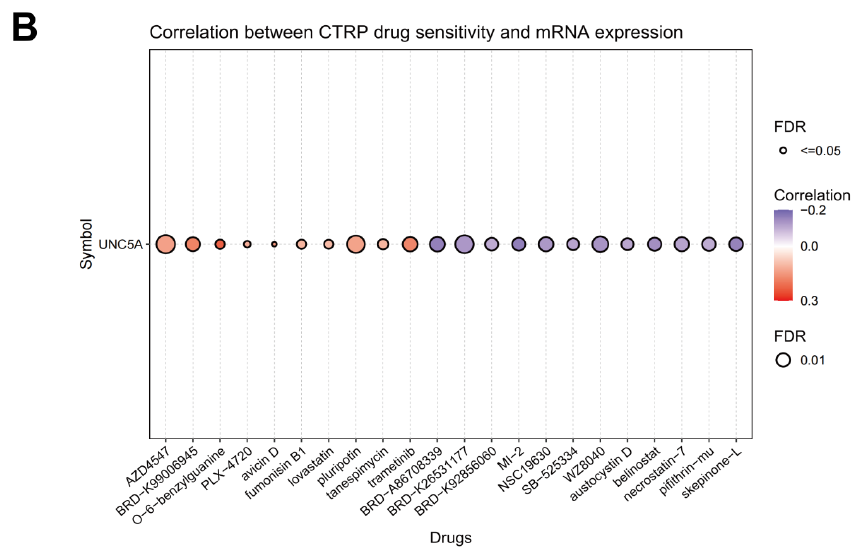
Figure 12. The relationship between UNC5A expression and drug sensitivity basis CTRP and GDSC databases. ( A ) UNC5A expression was positively related to various targeted or chemotherapeutic agents in GDSC database. ( B ) UNC5A expression was related to various targeted or chemotherapeutic agents in CTRP